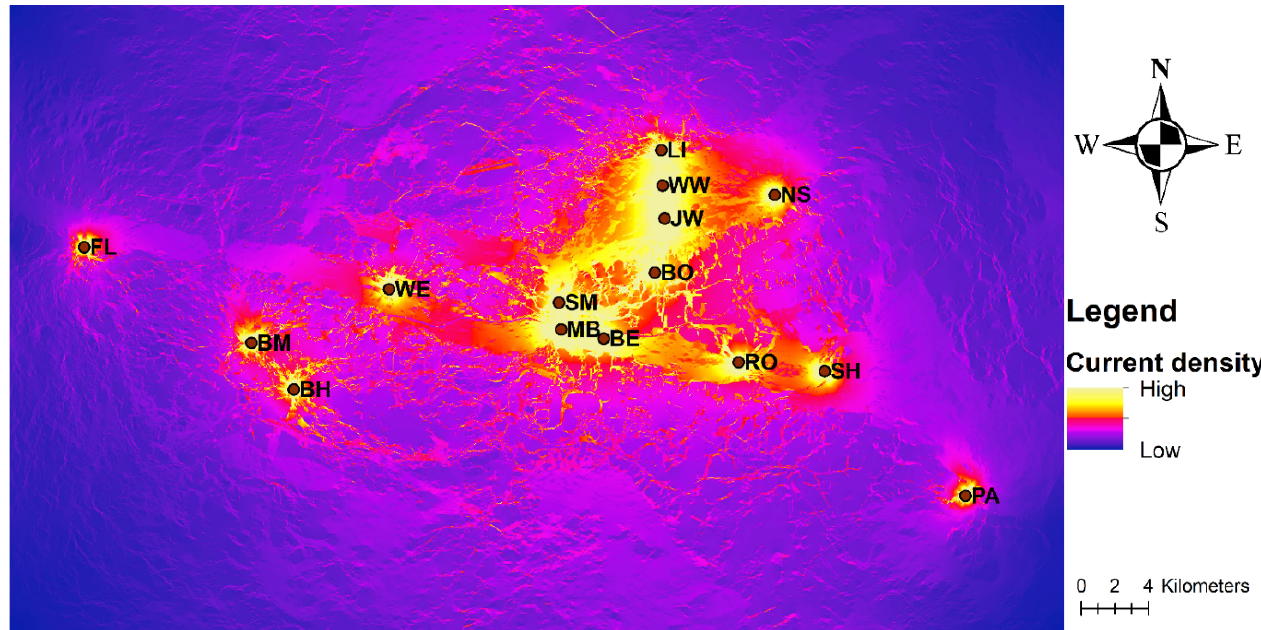
Figure 4. Current density map of the northern Weser Hills created with Circuitscape and ArcMap. Current density between 15 focal nodes is shown.